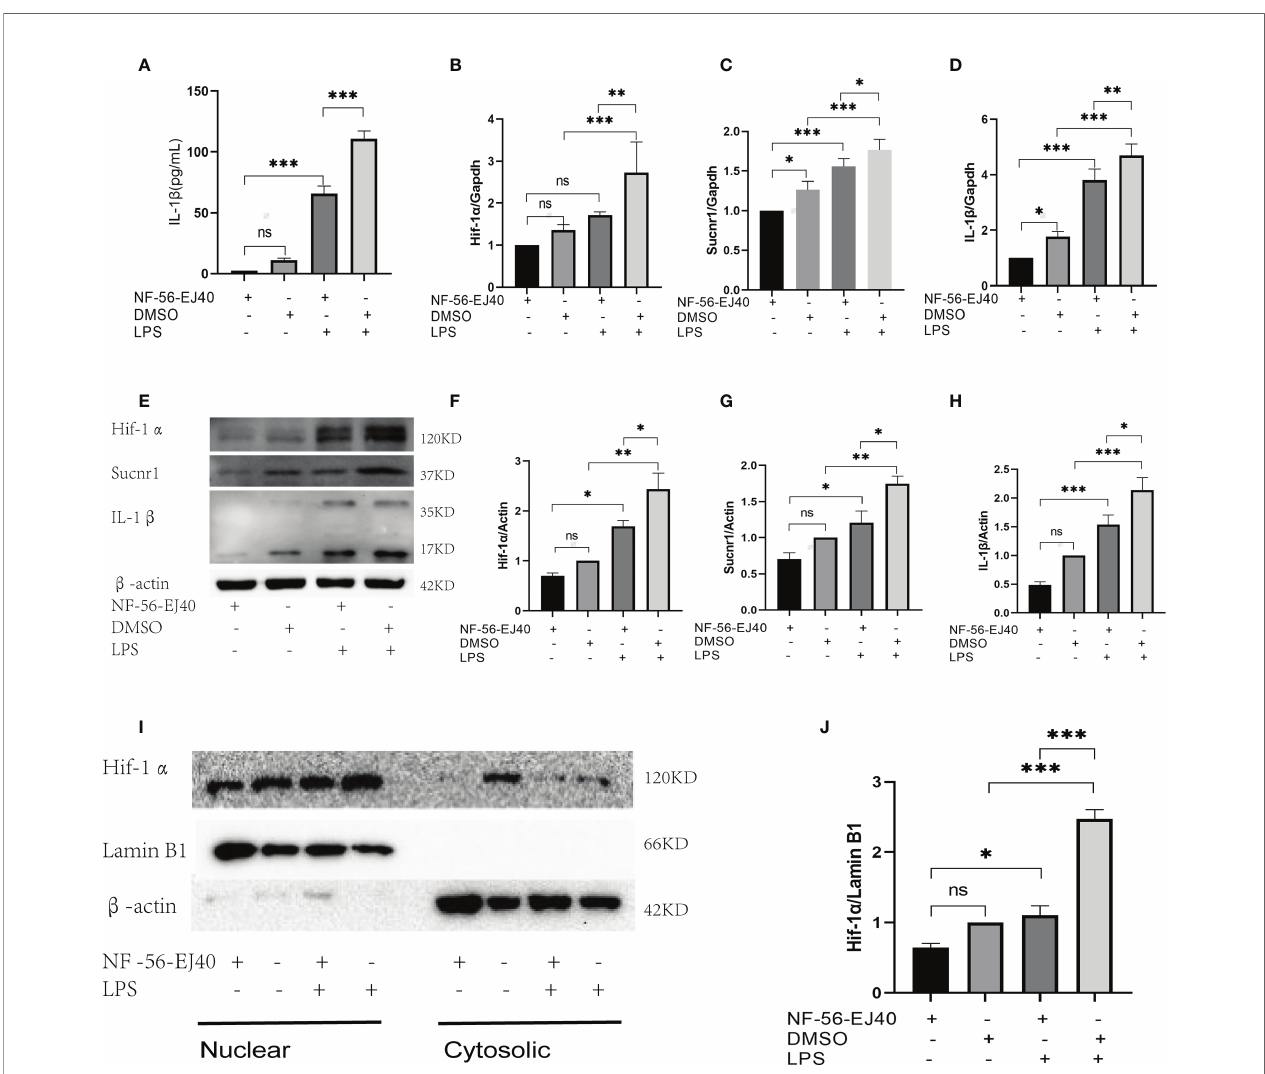
FIGURE 4 | Sucnr1 antagonist inhibits succinate/IL-1 b signal axis in macrophages. Macrophages were divided into four groups and given intervention according to design: NF-56-EJ40 group, DMSO group, NF-56-EJ40 and LPS group, DMSO and LPS group. (A) IL-1 b of supernatant medium was detected via ELISA. (B – D) mRNAs of Sucnr1, Hif-1 a , and IL-1 b were tested using rt-PCR. (E – H) Expression levels of Sucnr1, Hif-1 a , and IL-1 b were displayed via Western blots. (I, J) Expression levels of Hif-1 a in nucleus were detected using Western blots. Western blot data present mean ± SEM from three independent experiments at least. ELISA results represent mean ± SD from three different experiments at least. * P < 0.05; ** P < 0.01; *** P < 0.001; ns means no statistical